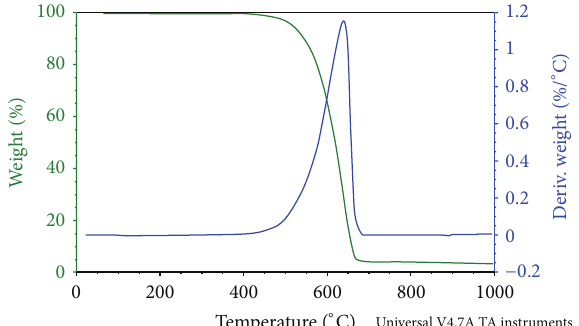
Figure 8: Temperature-dependent mass change (TG), rate of mass change (DTG) of raw CNTs.